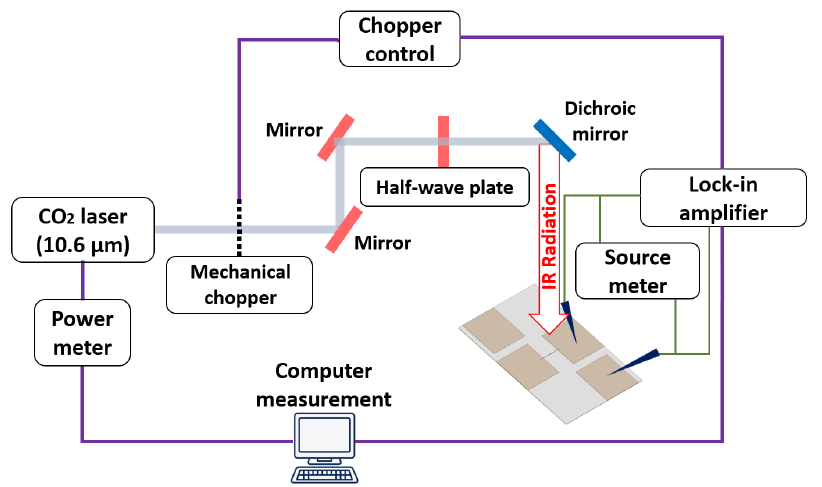
Figure 5. Schematic of the measurement setup.